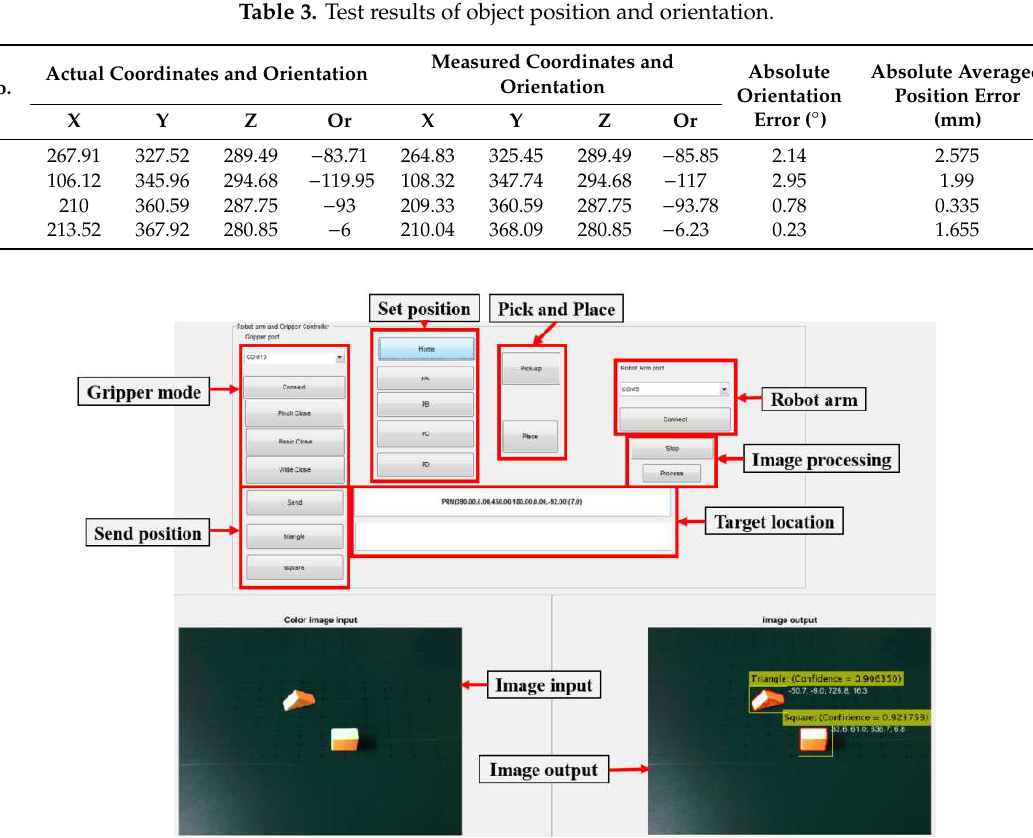
Table 3. Test results of object position and orientation.